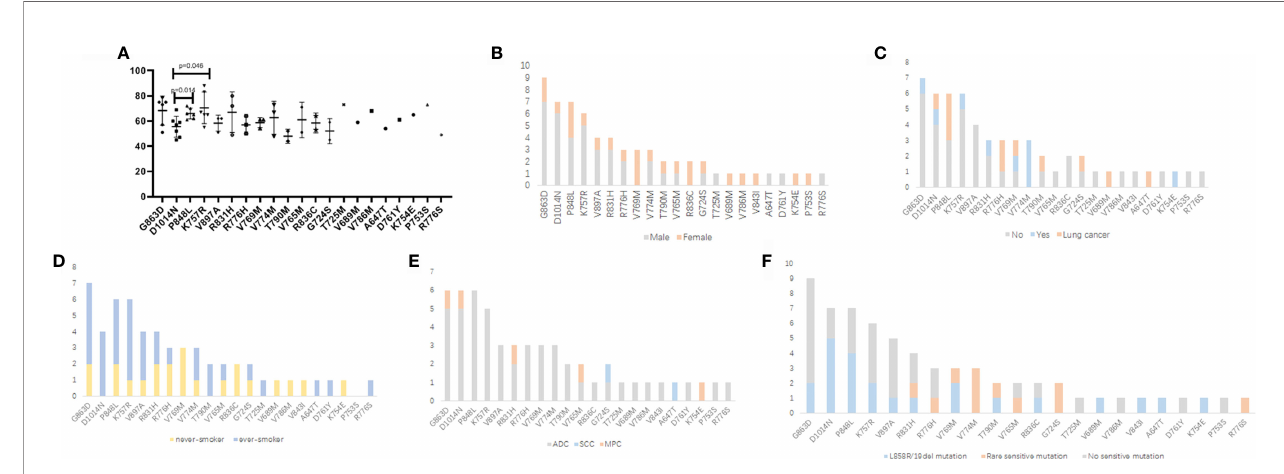
FIGURE 2 | Comparison of clinical and genetic features among patients with different EGFR germline mutations. (A) Age at diagnosis (years). (B) Gender. (C) Cancer family history. (D) Smoking history. (E) Histologic subtype. (F) Somatic EGFR- sensitive mutations. ADC, adenocarcinoma; SCC, squamous cell carcinoma; MPC, multiple primary carcinoma.